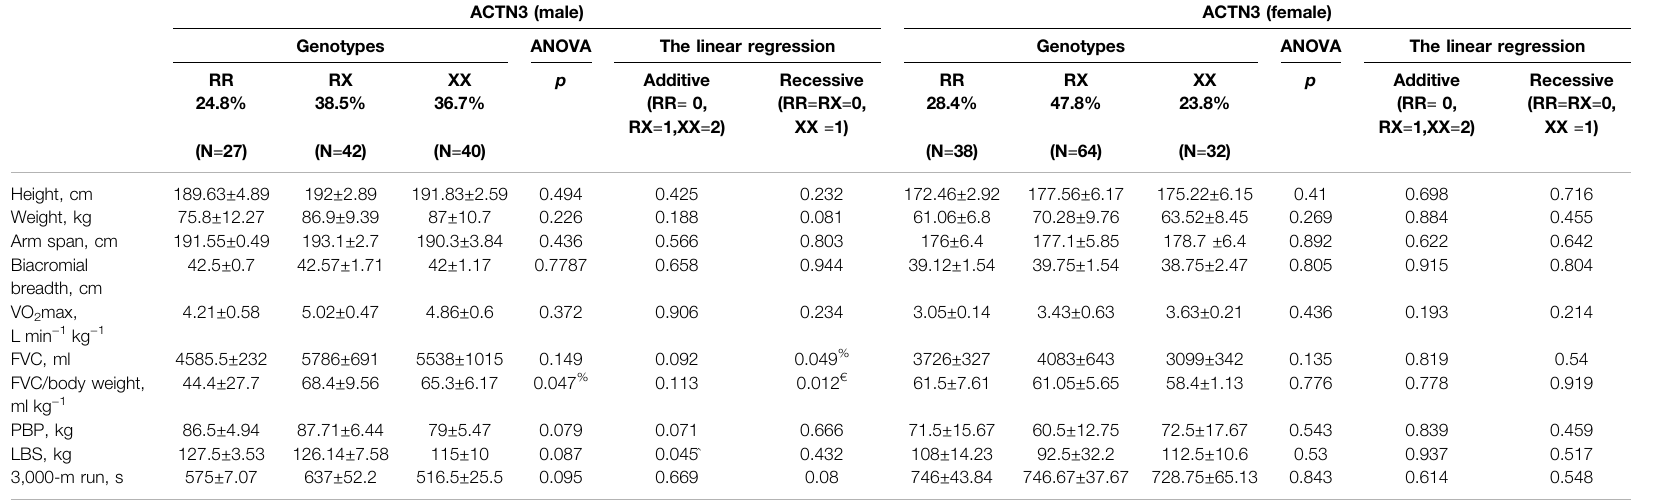
Notes: % indicates that a signi fi cant difference between the trait variables and ACTN3 three genotypes in male athletes ( p < 0.05); ^ indicates that the linear regression analysis of trait variables and ACTN3 genotypes based on ACTN3 X dominantgeneticeffecthasstatisticalsigni fi canceinmaleathletes( p < 0.05); € indicatesthatthelinearregressionanalysisoftraitvariablesandACTN3genotypesbasedonACTN3Rdominantgeneticeffecthasstatisticalsigni fi canceinmale athletes ( p <